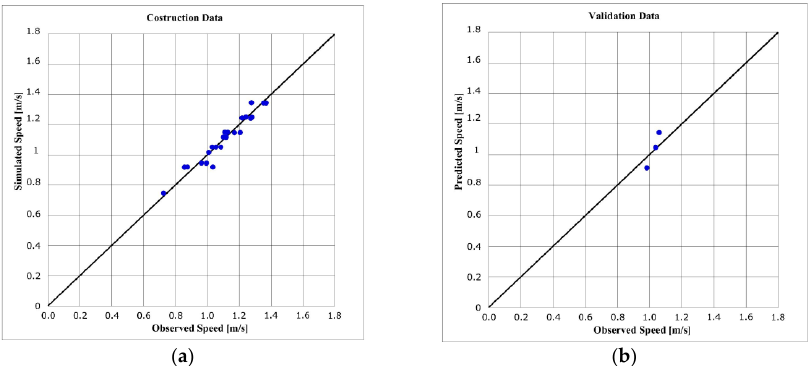
Figure 9. Comparison between observed and estimated dataset: construction phase ( a ); validation phase ( b ).